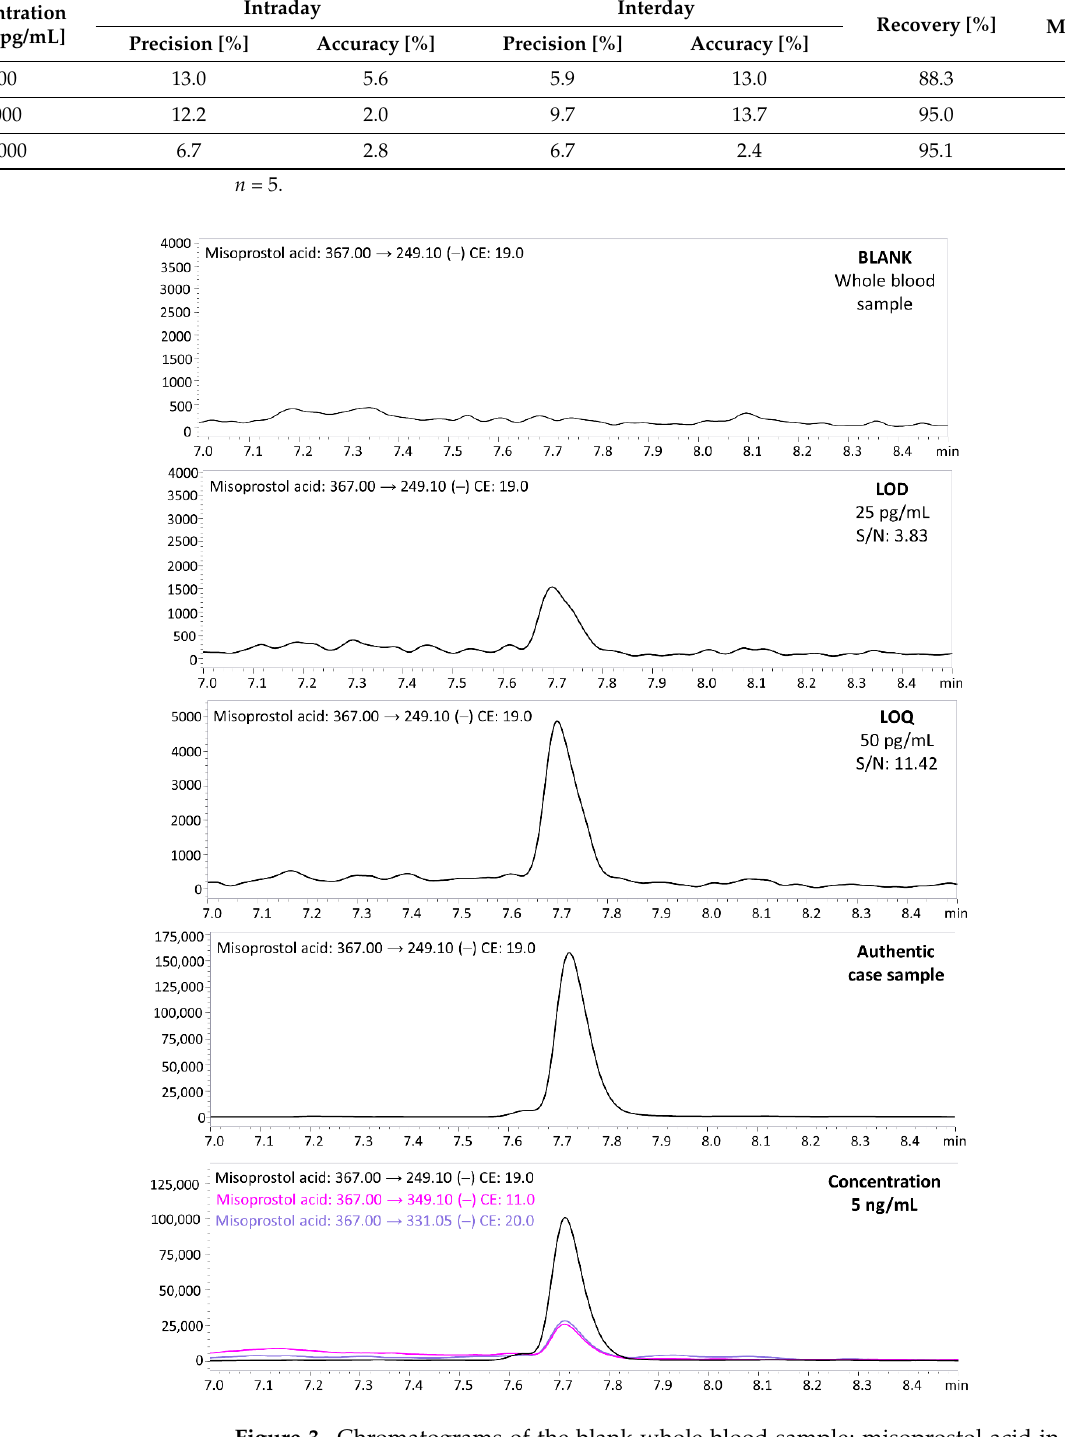
Figure 3. Chromatograms of the blank whole blood sample; misoprostol acid in blood at a concentration of LOD (25 pg/mL); misoprostol acid in blood at a concentration of LOQ (50 pg/mL); chromatogram of authentic placenta sample (Case 2); and misoprostol acid in whole blood at the concentration of 5 ng/mL (with all monitored MRM transitions).